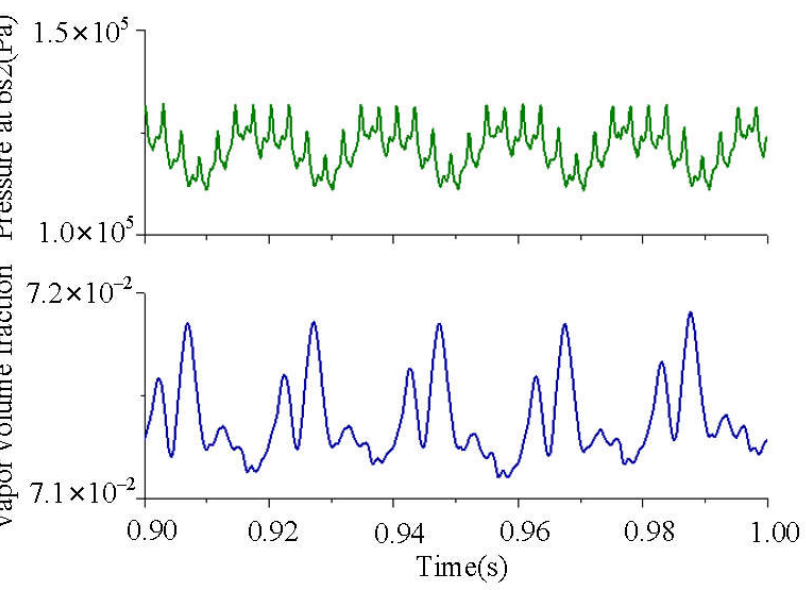
Figure 15. Pressure at bs2 and volume fraction of vapor at the impeller at 0.9–1.0 s.